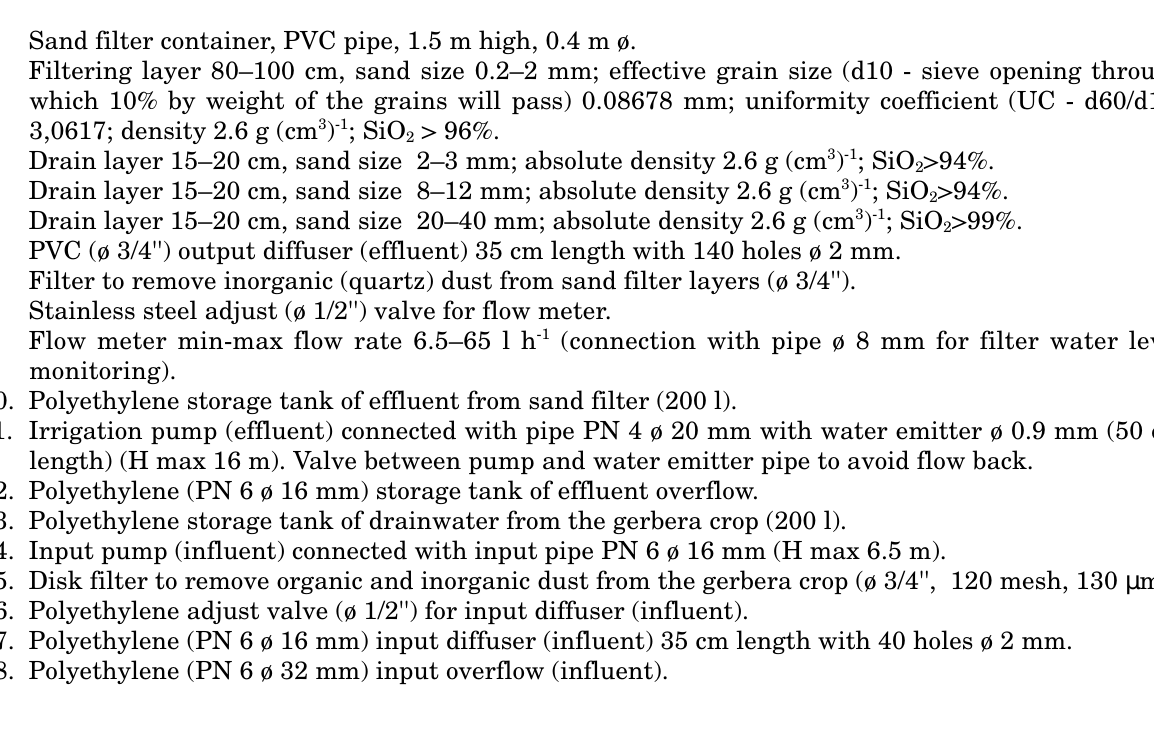
Fig. 1. Technical characteristics of the sand